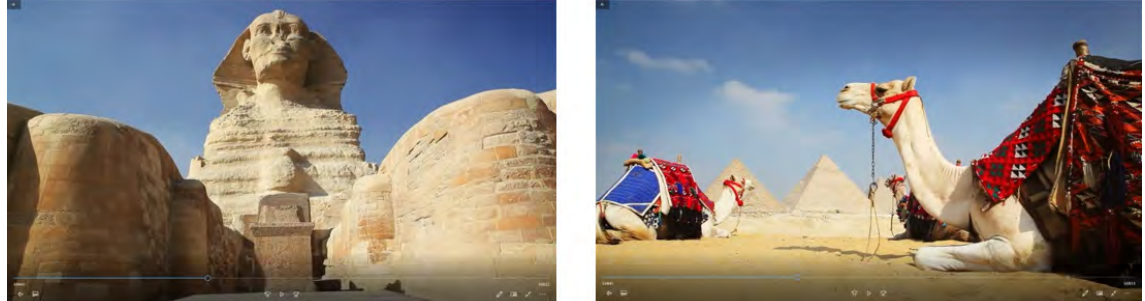
Figure 12. Shows the iconic great pyramids in Giza(New Egypt Old Friends,